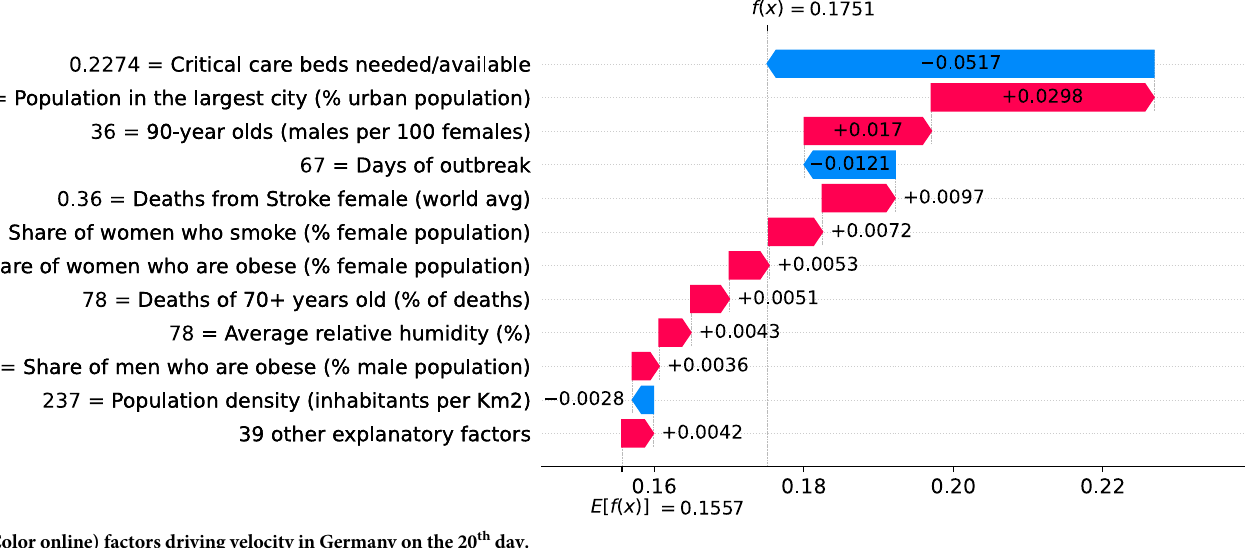
Fig 22. (Color online) factors driving velocity in Germany on the 20 th